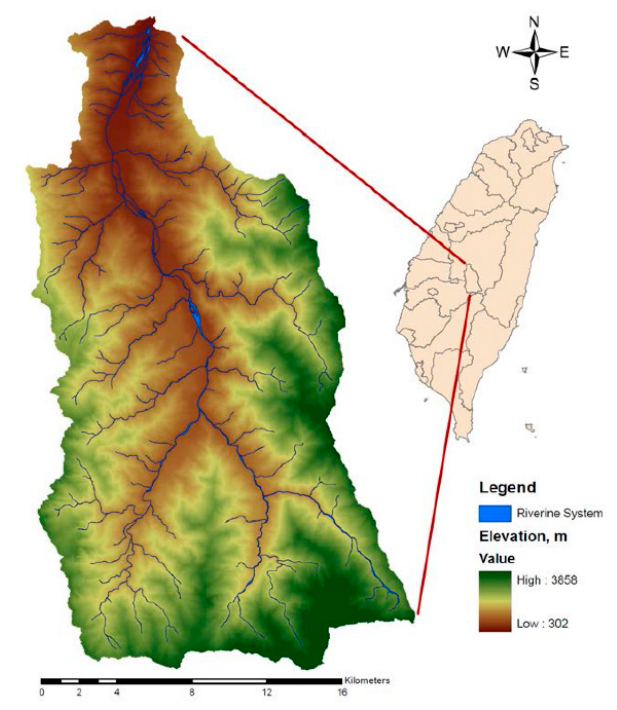
Figure 1. The Chenyulan river watershed and its riverine system in Taiwan.